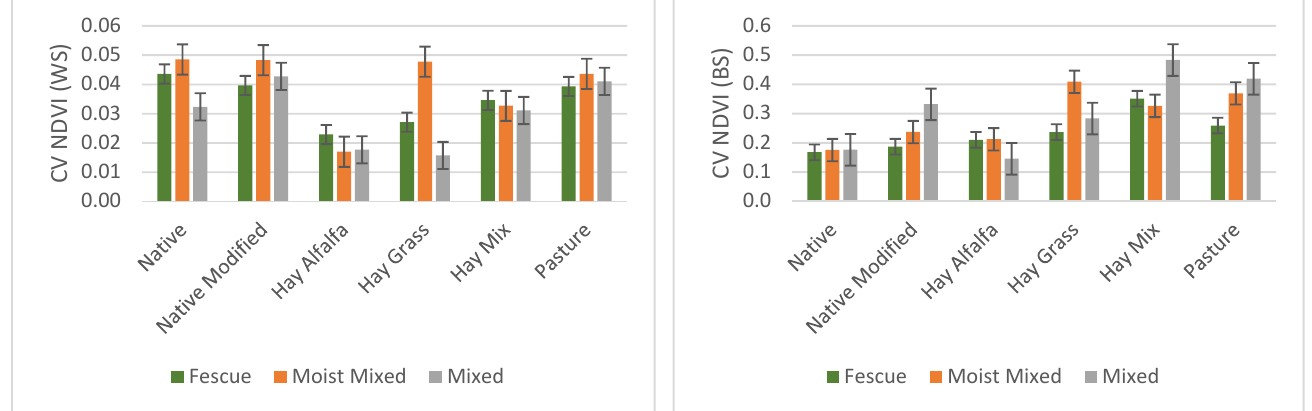
Figure 6. The within-sites (WS) and between-sites (BS) NDVI coefficient of variation (CV) for six land cover types located at three ecoregions.